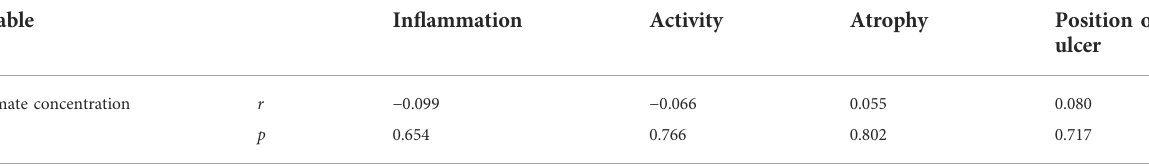
TABLE 2 Correlation of glutamate concentration with pathologic